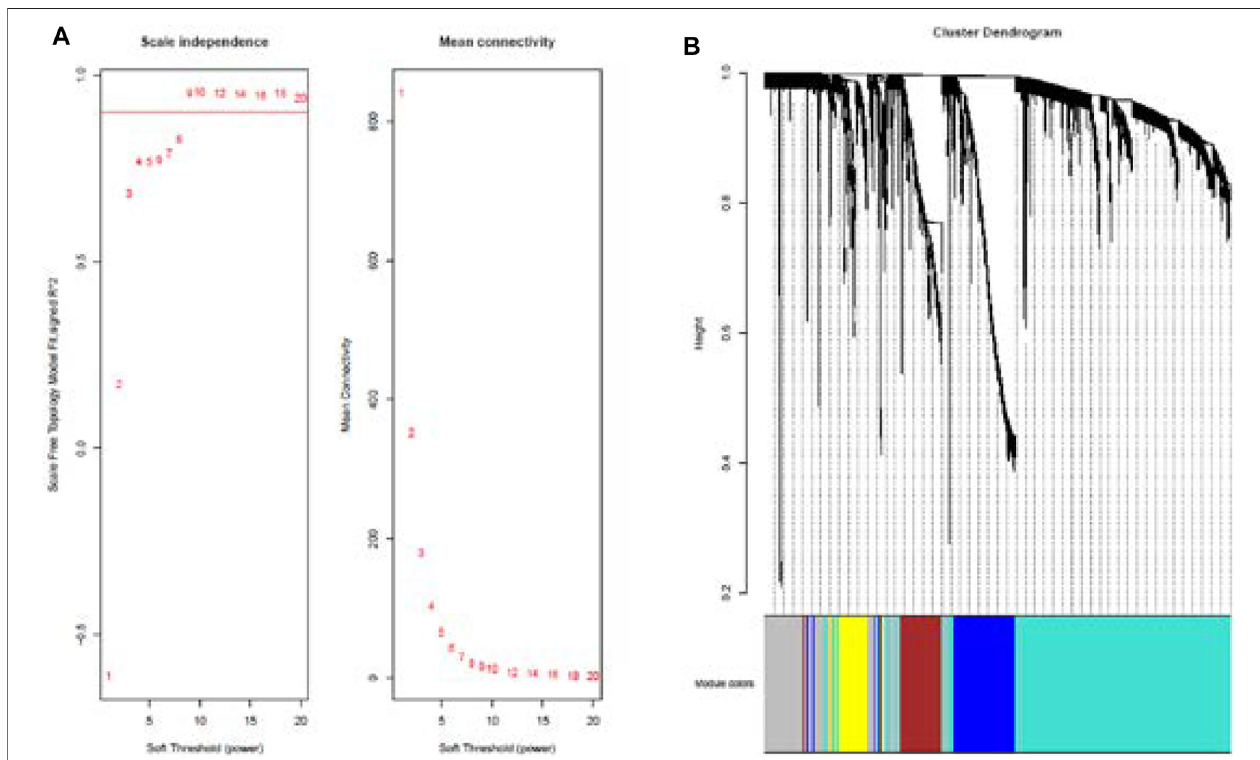
FIGURE 2 | Analysis of network topology for various soft-thresholding powers (A) . Summary network indices ( y -axes) as functions of the soft-thresholding power ( x -axes). Numbers in the plots indicate the corresponding soft-thresholding powers. The plots indicate that approximate scale-free topology is attained around the soft- thresholdingpowerof9forthesets.Because thesummaryconnectivitymeasures declinesteeplywithincreasingsoft-thresholdingpower, itisadvantageous tochoose the lowest power that satis fi es the approximate scale-free topology criterion. Cluster dendrogram and co-expression network modules for differentially expressed genes in the nasal epithelium of lung cancer and benign pulmonary nodule (B) . Gene dendrogram obtained by clustering the dissimilarity based on consensus topological overlap with the corresponding module colors indicated by the color